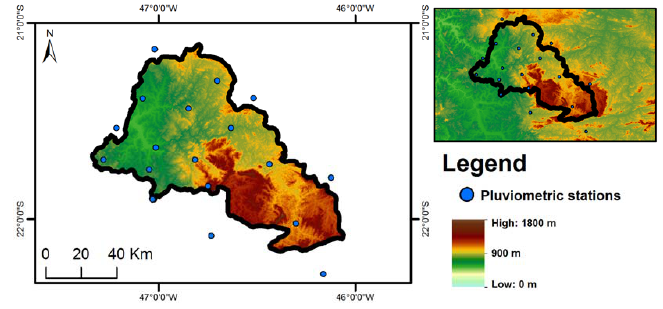
Figure 2. Elevation and pluviometry stations in the Alto Pardo watershed.